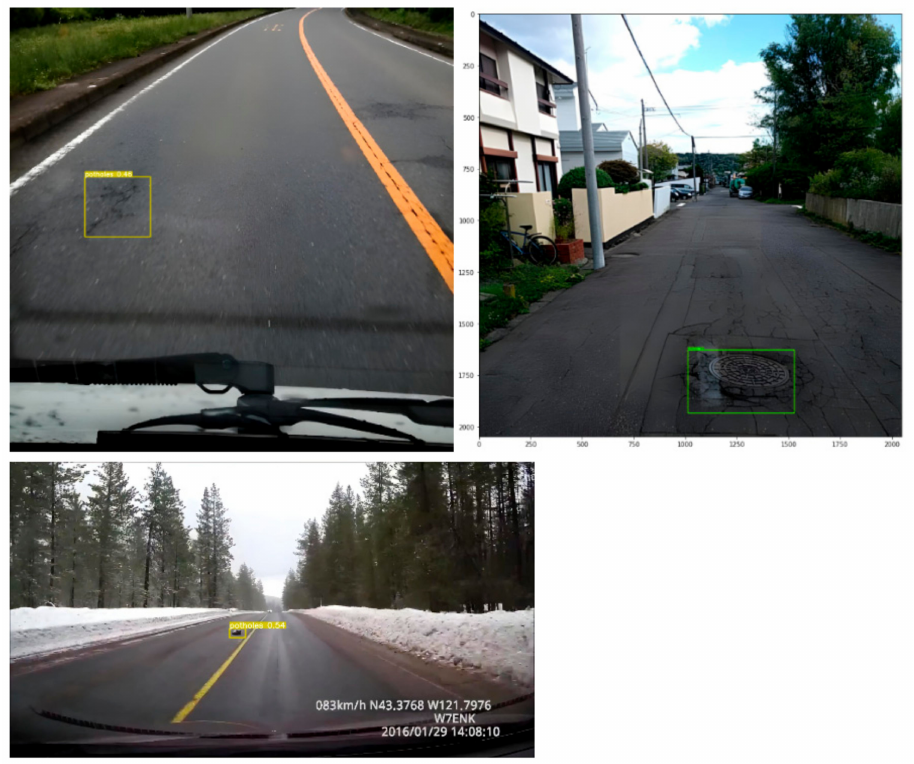
Figure 7. Misclassifications experienced during validation, where a manhole cover, crack, and black nylon are classified as pothole